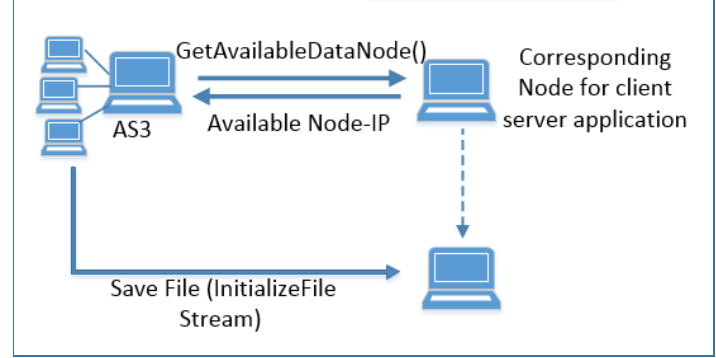
Figure 4. File storage processing.